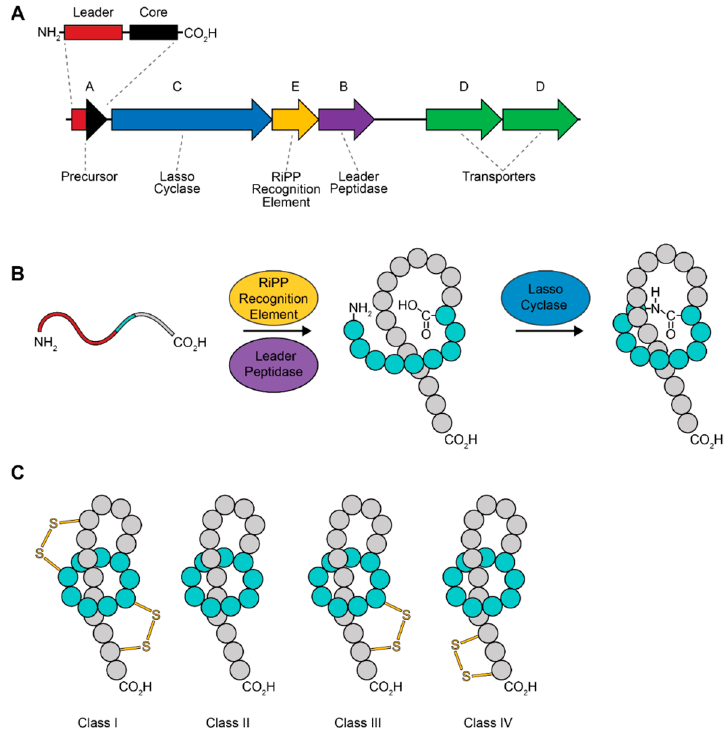
Figure 2. Biosynthesis of lasso peptides. ( A ) General overview of lasso peptide biosynthetic gene clusters including the lasso cyclase, RiPP recognition element (RRE), leader peptidase, and the precursor peptide. ( B ) Processing of the precursor peptide into the mature lasso peptide. ( C ) Comparison of different classes of lasso peptides.